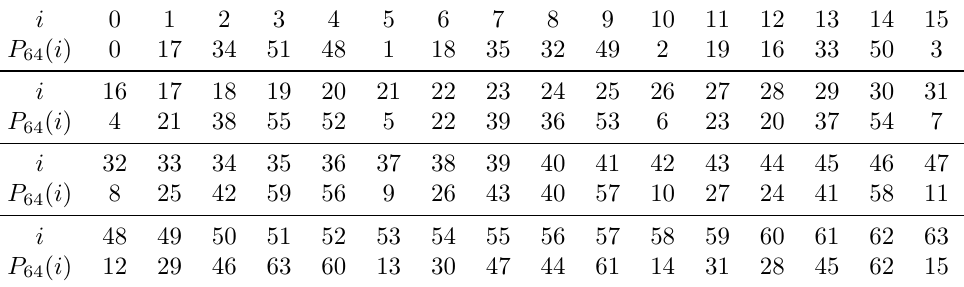
Table 9: GIFT-64 ’s bit permutation